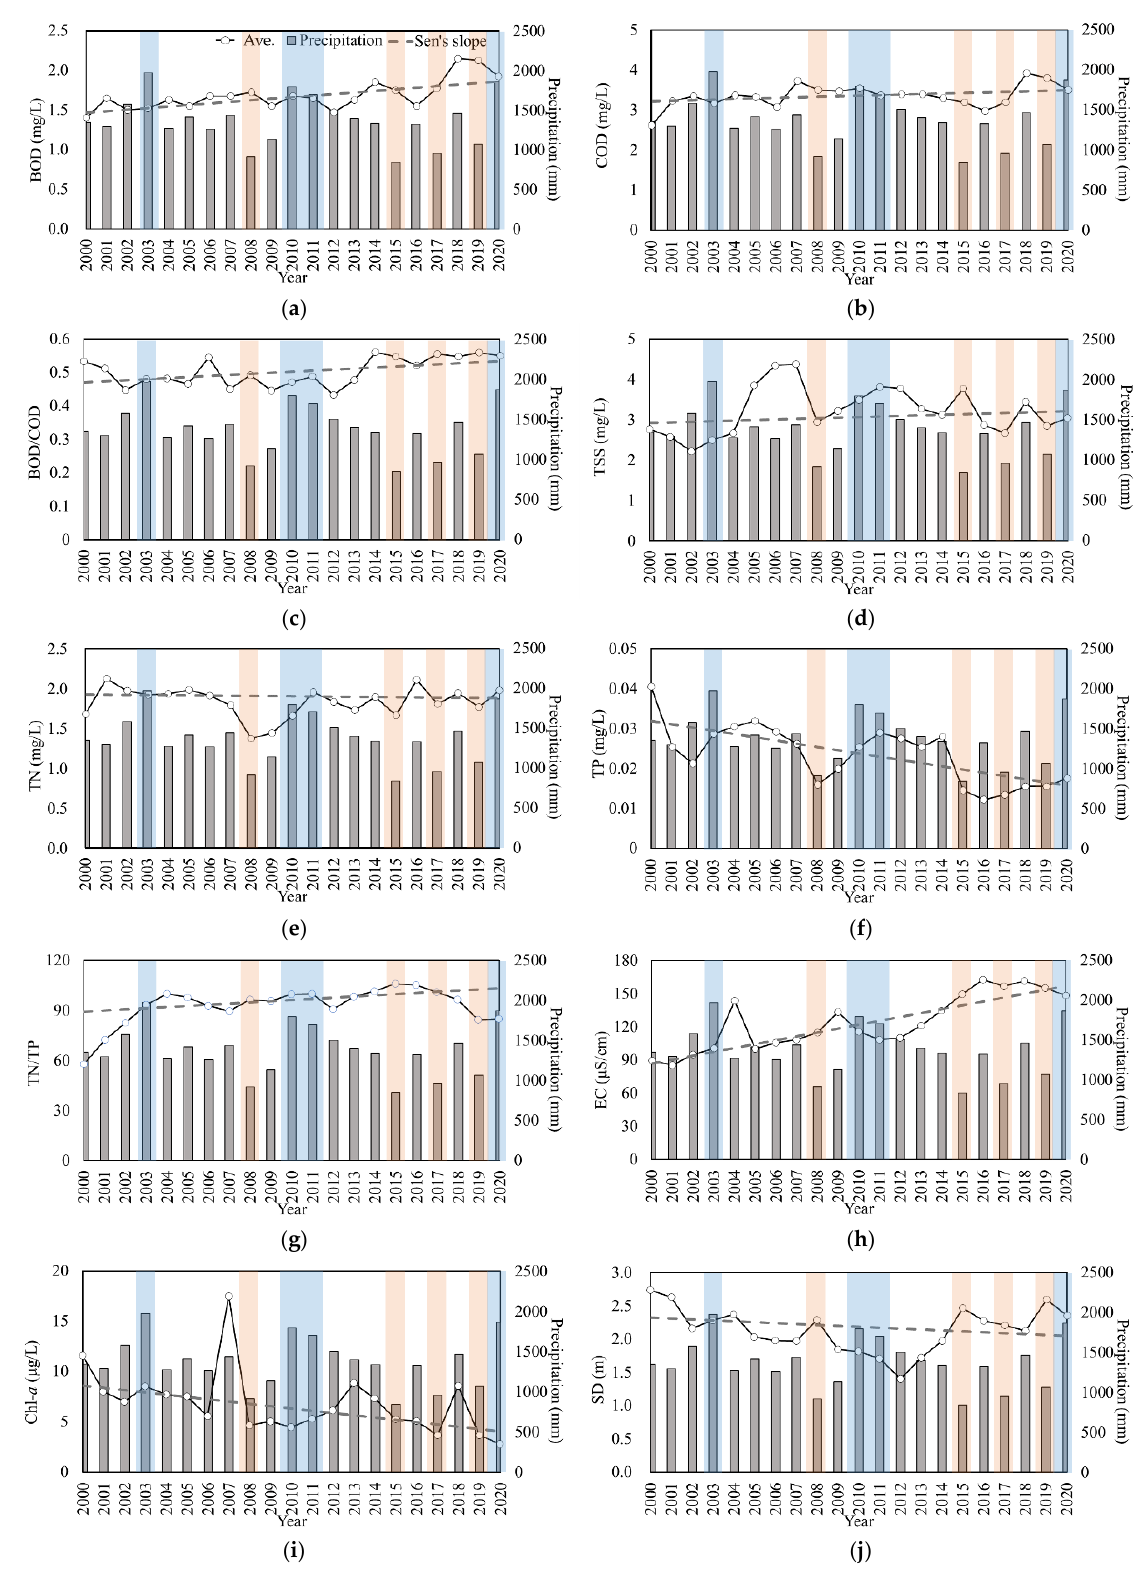
Figure 3. Yearly variation of water quality parameters and the results of the long-term trend analysis: ( a ) BOD, ( b ) COD, ( c ) BOD/COD, ( d ) TSS, ( e ) TN, ( f ) TP, ( g ) TN/TP, ( h ) EC, ( i ) Chl- a , and ( j ) SD. Bar graphs in the background display the total annual precipitation. The shaded areas in blue and pink represent the flood and drought years,